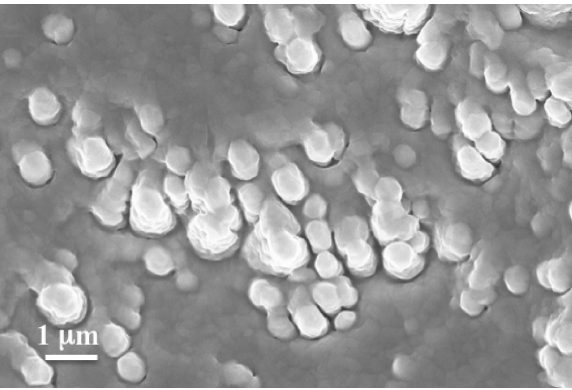
Figure 1. Surface SEM micrograph of ZrVTi1 sample deposited at 350 °C. Conversely, with the temperature set at 150 °C during deposition, membranes showed homogeneous, compact, and dense films, as revealed by SEM micrographs of the top surface. No pores or defects were detected. Figure 2 reports two representative surface SEM micrographs of ZrVTi2 and ZrVTiPd3 samples.